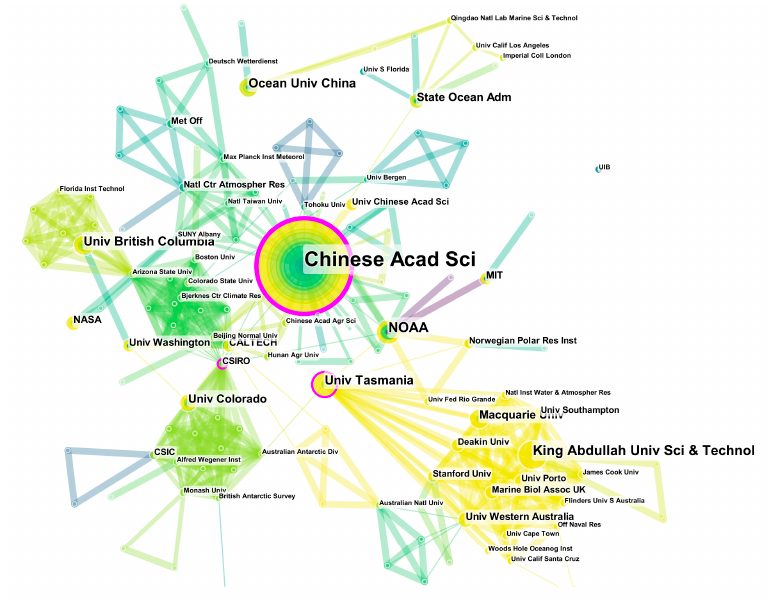
Figure 4. Institutional collaboration network map. Table 2 organizes the top 10 prolific institutions sorted by count and centrality of Table 2. Top 10 most productive institutions regarding big ocean data documents.